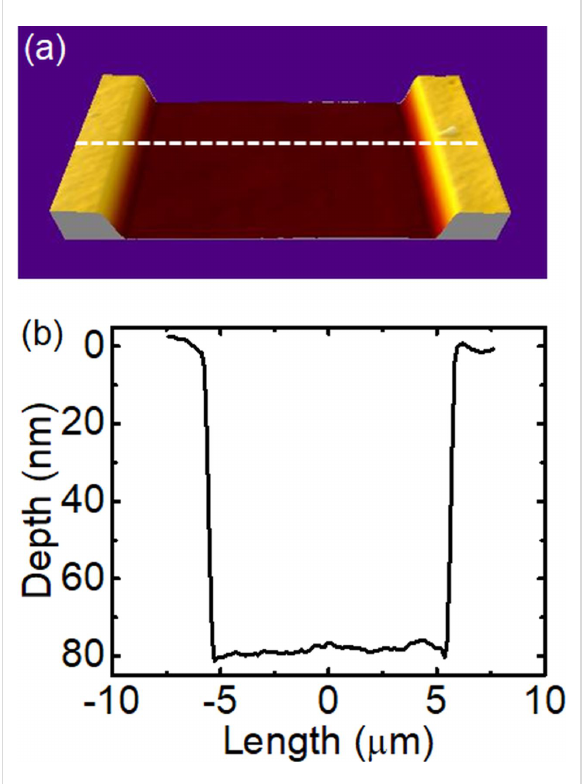
Figure 1: (a) AFM image and (b) the corresponding depth profile of a fragment of the surface depression produced in a 5 nm Pt 60 Pd 40 / 200 nm PMMA sample by irradiation with He + FIB at an energy of 25 keV and with a fluence of 1.0 × 10 16 cm − 2 . The dashed line in (a) indicates the place of the depth profile.